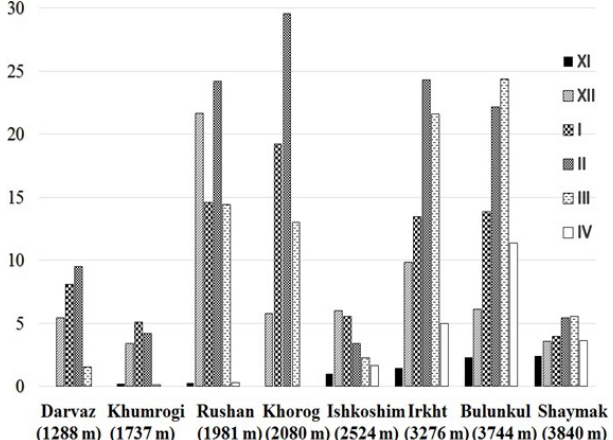
Figure 6. The average long-term monthly snow covers at the me- teorological stations of the Pyanj River Basin for the period 1944–